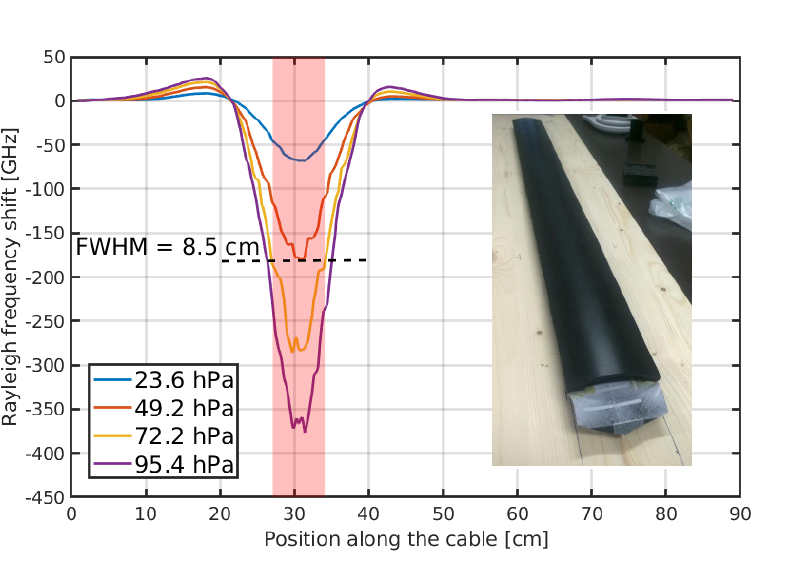
Figure 3. Response in terms of the Rayleigh frequency shift of the engineered cable proposed in [99] and shown in the inset as a function of the local pressure applied over the 7 cm-wide area around 30cm. The corresponding full-width-half-maximum (FWHM) response extends up to 8.5cm, showing a moderate non-local response of the cable to the pressure